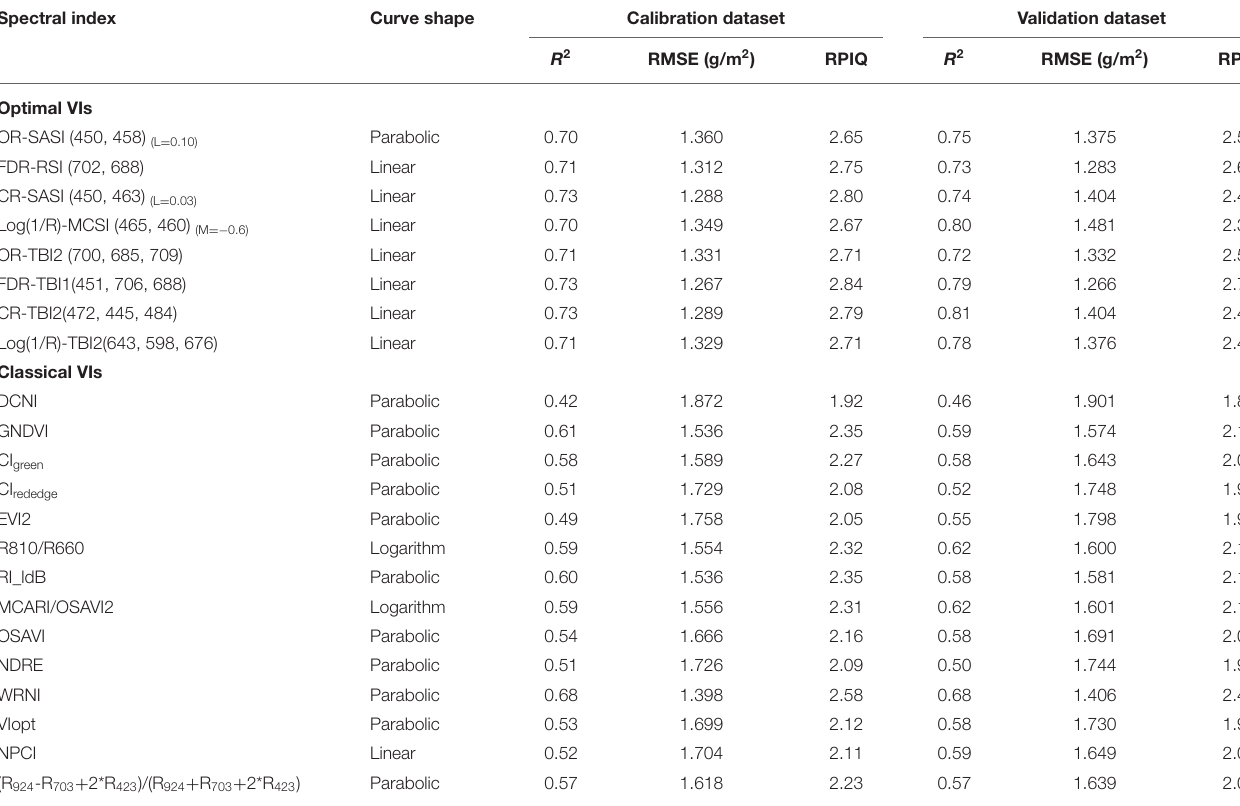
TABLE 4 | Quantitative models of leaf nitrogen accumulation to selected spectral indices and classical vegetation indices in winter wheat. Spectral index Curve shape Calibration dataset